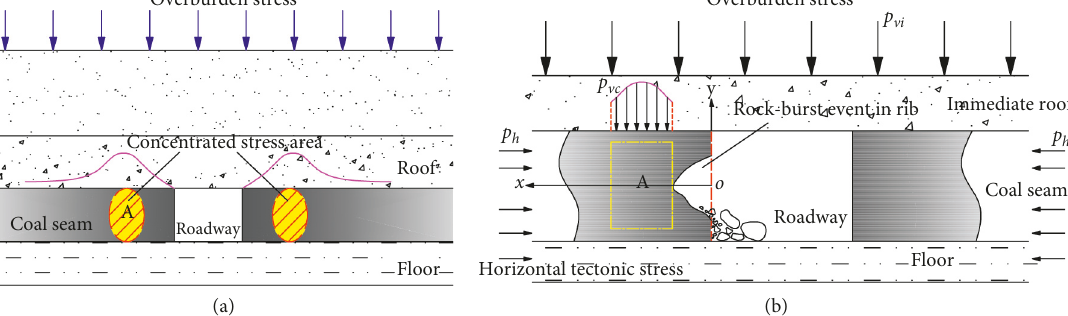
Figure 3: The schematic diagram of occurrence mechanism of rock burst in roadway rib. (a) Before the occurrence of rock burst; (b) after the occurrence of rock